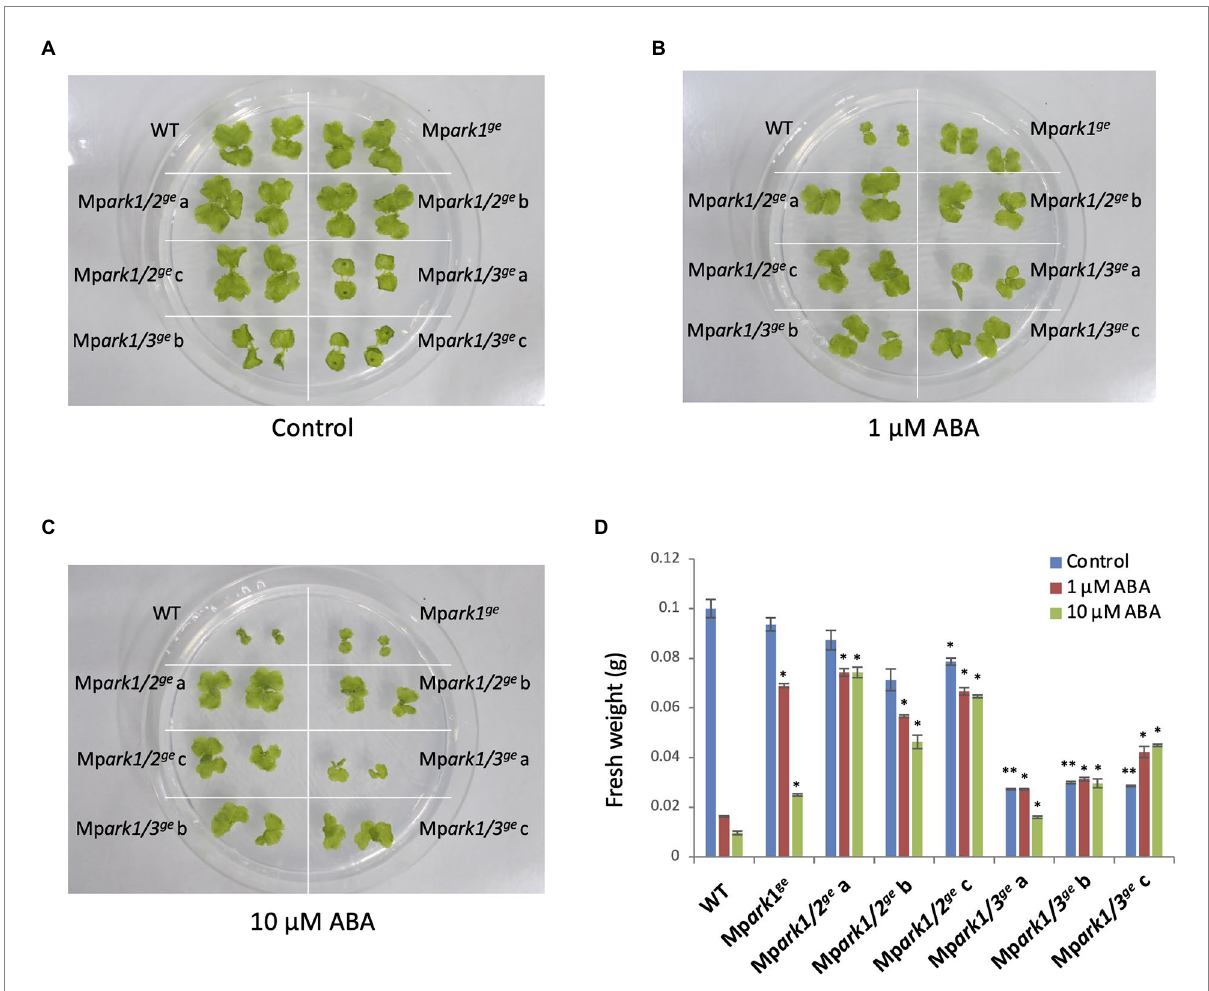
FIGURE 2 Effect of ABA on growth of gametophytes of M. polymorpha . Gemmae of wild type (WT) and three each of double mutant lines of Mp ARK1 and Mp ARK2 (Mp ark1/2 ge a to c) and Mp ARK1 and Mp ARK3 (Mp ark1/3 ge a to c) were grown on medium without ABA (control) (A) or with 1- μ M (B) or 10- μ M (C) ABA for 14 days. (D) Fresh weight of the gemmalings was plotted in histograms. Error bars indicate the standard error ( n = 3). * p < 0.05 and ** p < 0.01 in the t -test compared with WT of the same